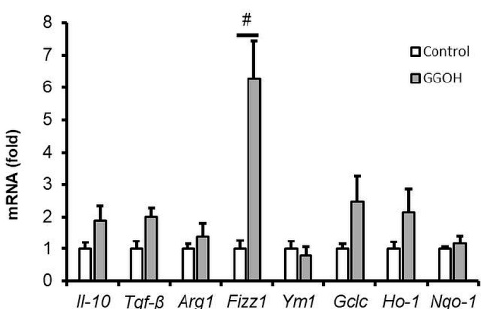
Figure 7. Non-regulation of the expression levels of M2 and Mox phenotype markers following geranylgeraniol (GGOH) administration. MG6 cells were pre-treated with or without GGOH (10 µM) for 24 h. Thereafter, mRNA expression levels were measured via qRT-PCR, normalized to the level of Eef1a1 (the internal standard), and expressed as the fold-change relative to the values corresponding to the control cells. Data are presented as the mean ± S.E.M, n = 3; # p < 0.05 vs. control.